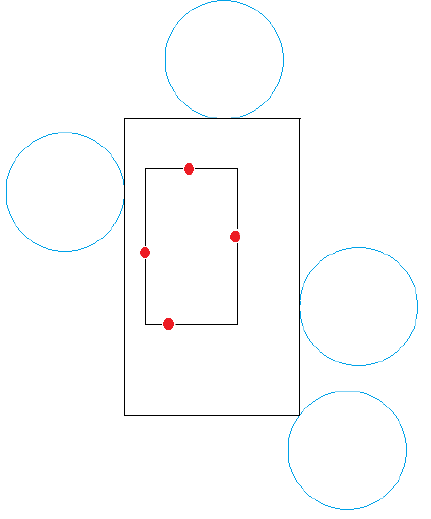
Figure 13. Case 1: Three circles pin the CSR on edges, which uniquely determines its fourth edge.